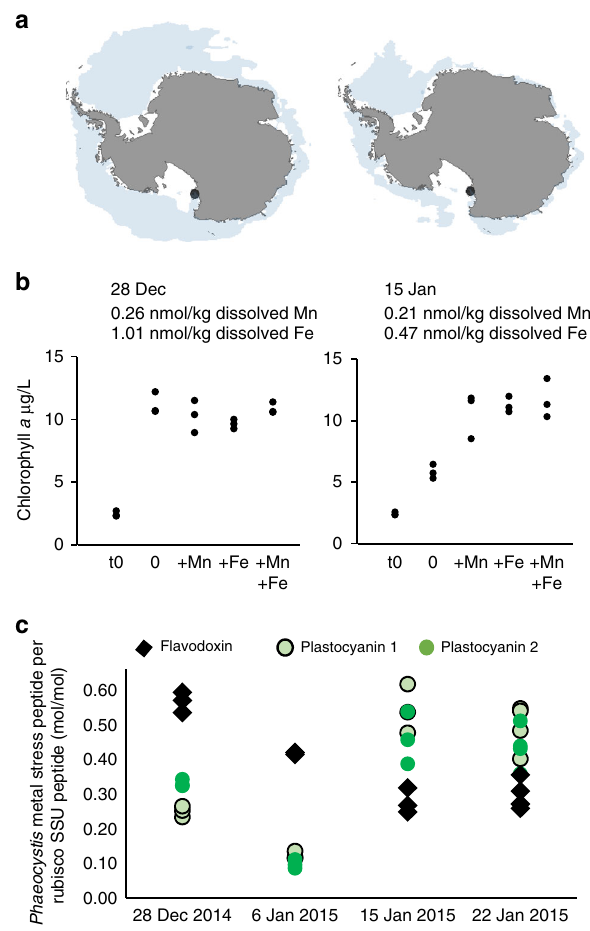
Fig. 5 Transition into Mn and Fe stress. Southern Ocean protein expression patterns, dissolved trace metal measurements, and bottle incubation bioassays suggest that over the course of a 4-week time series in McMurdo Sound, the phytoplankton community, Phaeocystis antarctica in particular, transitioned from metal replete to a state of Fe and Mn stress. a Maps demonstrating sampling location (black dot) and sea ice extent (blue) in December 2014 (left) and January 2015 (right). b Bioassay results (chlorophyll a production) upon Mn and Fe addition, relative to unamended treatments (0) and initial chlorophyll concentrations ( t 0), shown with in situ dissolved Mn and Fe concentrations. Dots represent a single biological replicate, three independent biological replicates per treatment. c Expression of metal-responsive Phaeocystis peptides fl avodoxin and plastocyanin normalized to constitutively expressed Phaeocystis -speci fi c peptides derived from the rubisco small subunit protein, given as mol/mol (Table 1). Source data are provided in the Source Data